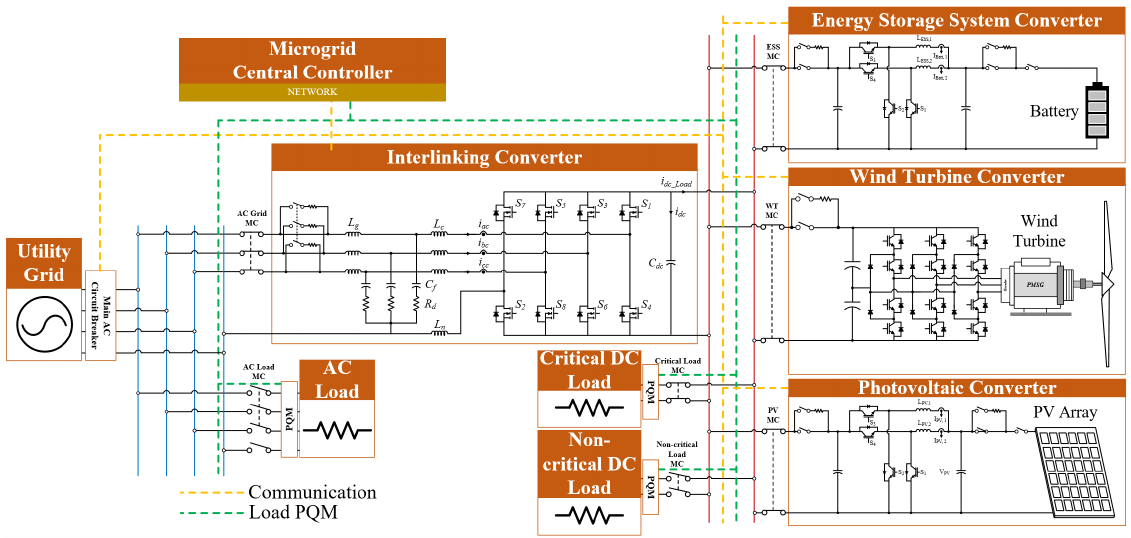
Figure 3. Microgrid configuration with DGs and loads.